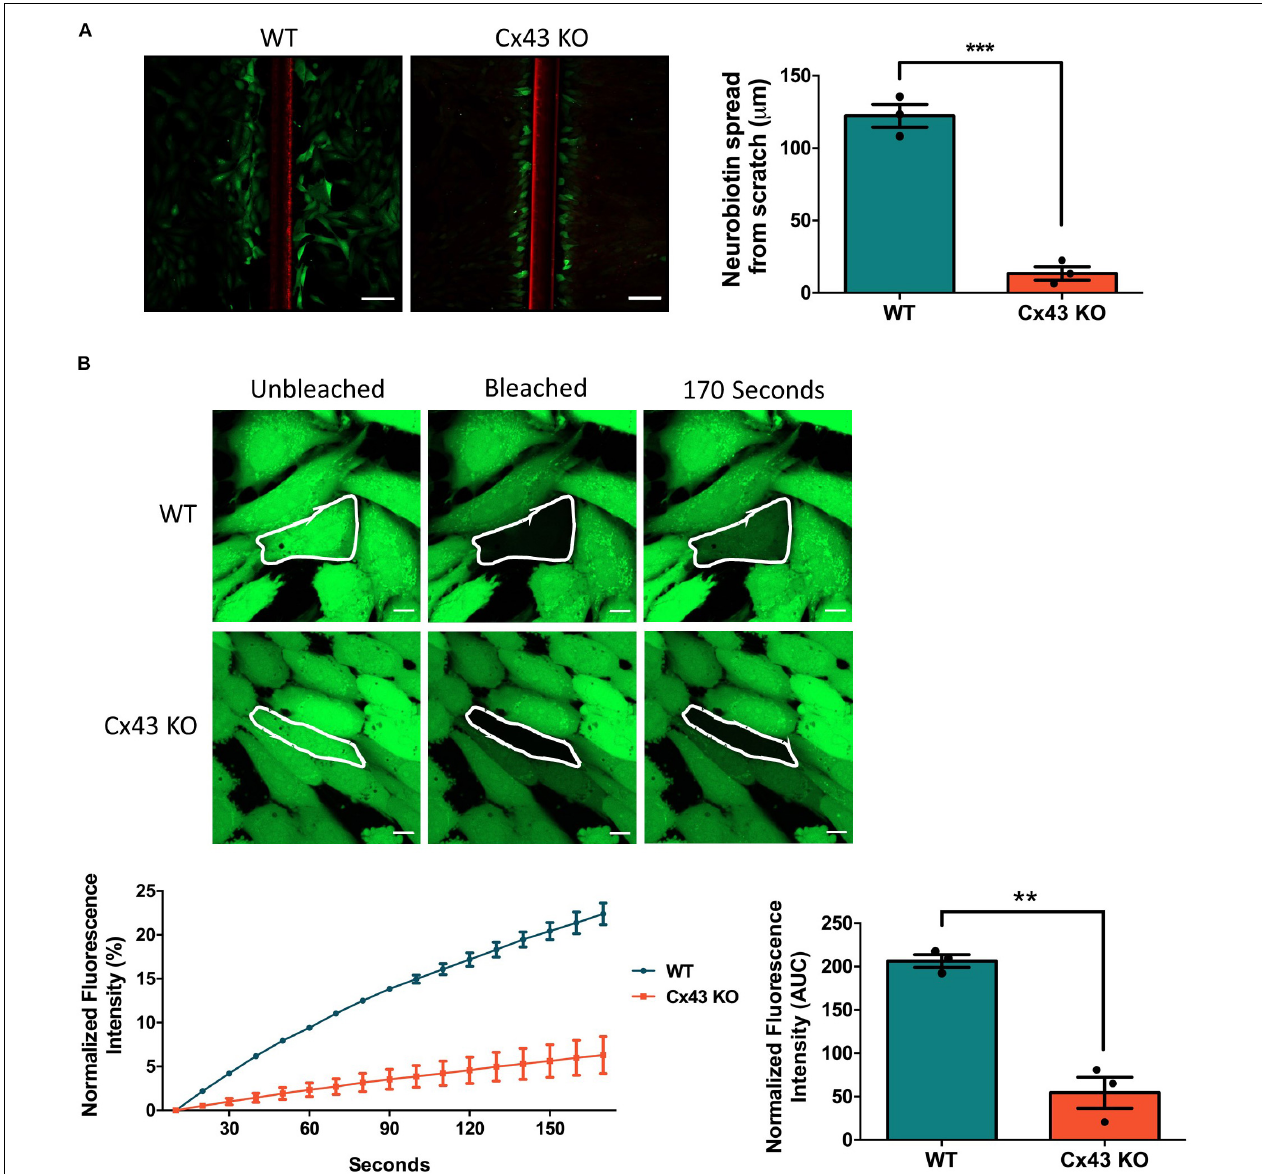
FIGURE 2 | Ablation of Cx43 greatly reduces dye transfer. (A) Representative micrographs of a scrape loading dye transfer assay performed on WT and Cx43 KO HEI-OC1 cells. Cells were scraped and incubated with the gap junction permeable tracer neurobiotin (green) and impermeable dextran rhodamine dye (red) that typically gets washed out during the sample preparation. Cx43 KO cells exhibited significantly less neurobiotin transfer from the first row of damaged cells than WT cells. (B) Representative micrographs of WT and Cx43 KO cells loaded with calcein-AM and subjected to fluorescence recovery after photobleaching of a selected cell (outlined in white). Dye recovery and area under the curve (AUC) was measured over 170 s. Cx43 KO cells had significantly less dye recovery after photobleaching compared to WT cells. Data represent mean ± SEM from three independent experiments and were analyzed using an unpaired t -test. *** p < 0.001, ** p < 0.01. Bars in (A) = 100 µ m and (B) = 10 µ